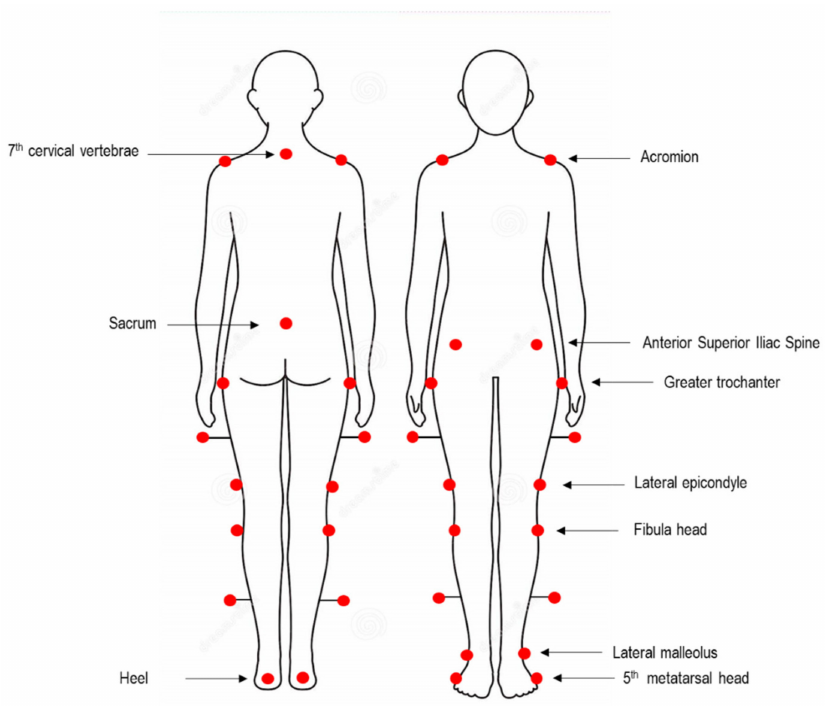
Figure 2. Graphic representation of markers placement according to the protocol proposed by Davis et al.